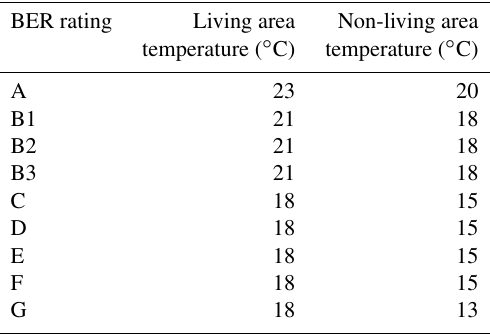
Table 8. Residential dwelling stock in 2018. Table 9. Internal temperature